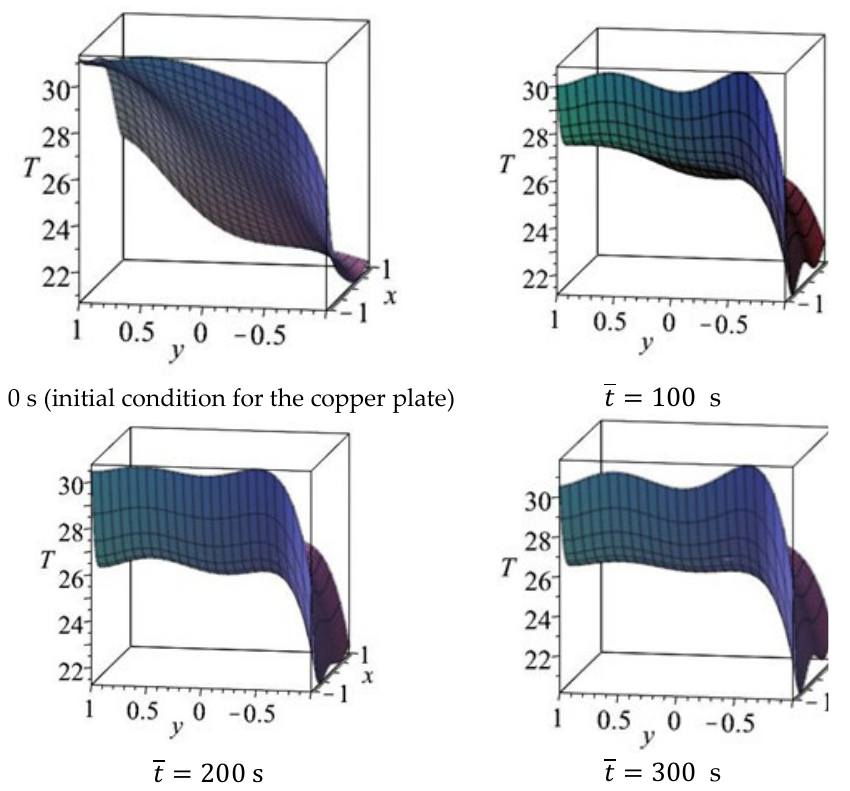
and for 4.5 °C , 𝑧𝑧 = 0 𝑇𝑇 𝜌𝜌 = 31 𝑣𝑣 𝑎𝑎 =